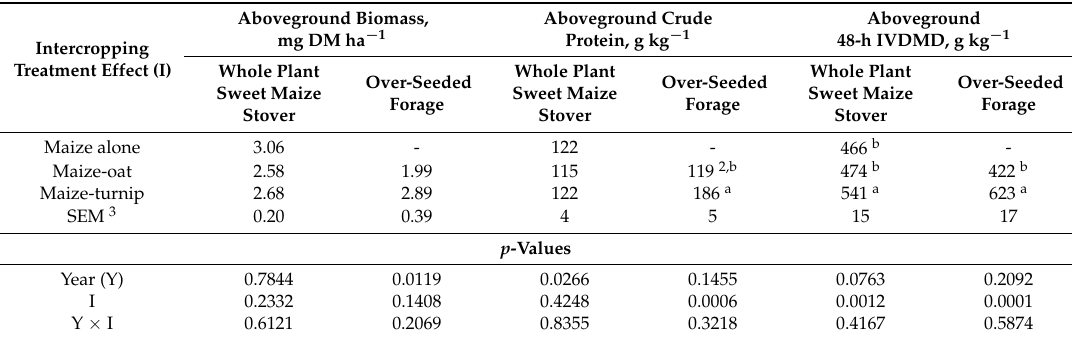
Table 2. Relay intercropping treatment main effect means of pre-grazing aboveground biomass dry matter (DM) yield, crude protein concentration, and 48-h in vitro dry matter disappearance (48-h IVDMD) of sweet maize stover alone or intercropped with oat or turnip and the overseeded forage species over two years at Alcalde, NM, USA 1